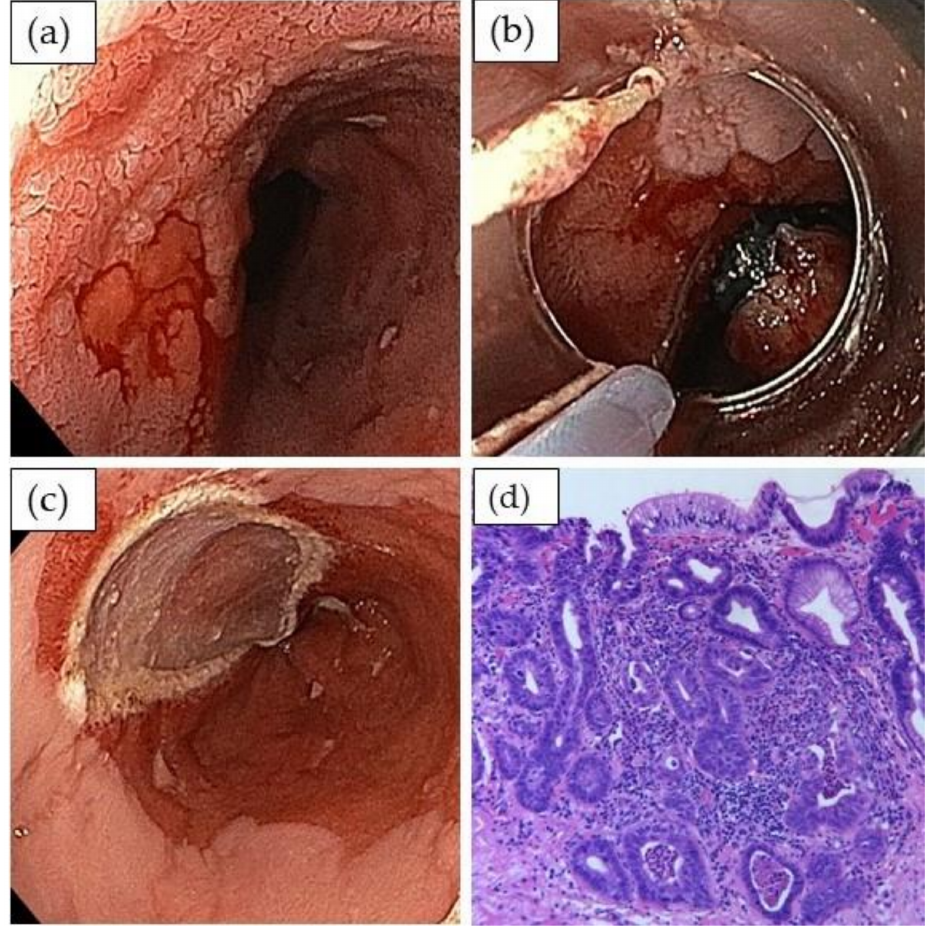
Figure 2. Endoscopic mucosal resection (EMR) of early adenocarcinoma with the suck and cut technique. ( a ) Long segment Barrett’s cancer with suspicious lesion to the left (white light imaging, acetic acid 1.5%); ( b ) lesion is band ligated and resected with the snare placed underneath the rubber band; ( c ) resection bed without any associated bleeding; ( d ) histopathology shows well differentiated